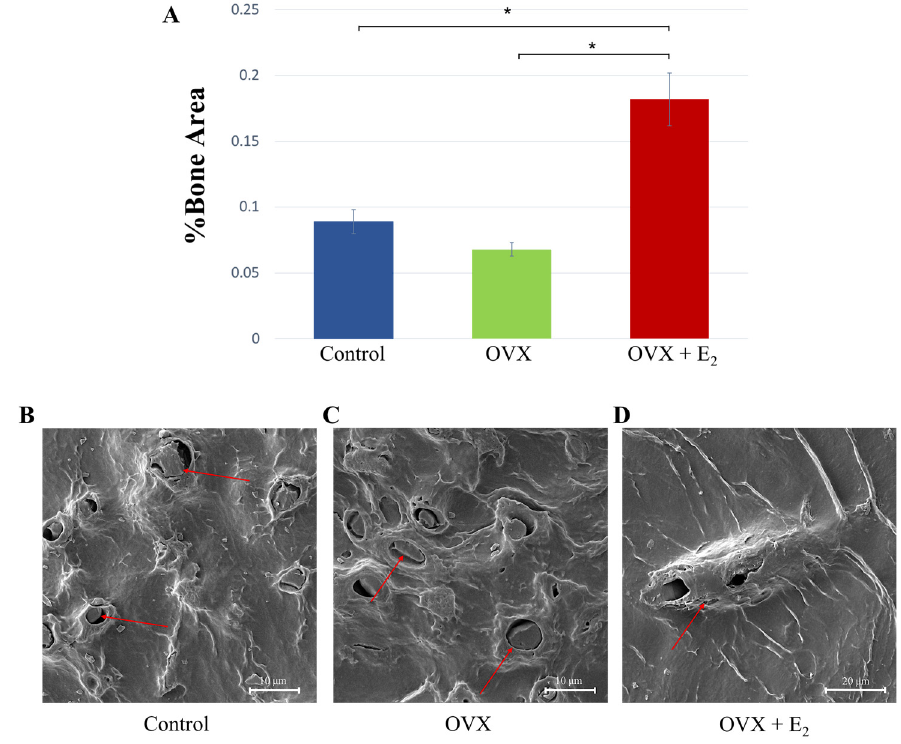
Figure 5. ( A ) %Trabecular bone was measured in each of the groups and the results showed a significant increase in the OVX + E 2 group * p < 0.05. ( B – D ) Scanning electron micrographs showing osteocytes within the lacunae (red arrows); an indication of bone viability.